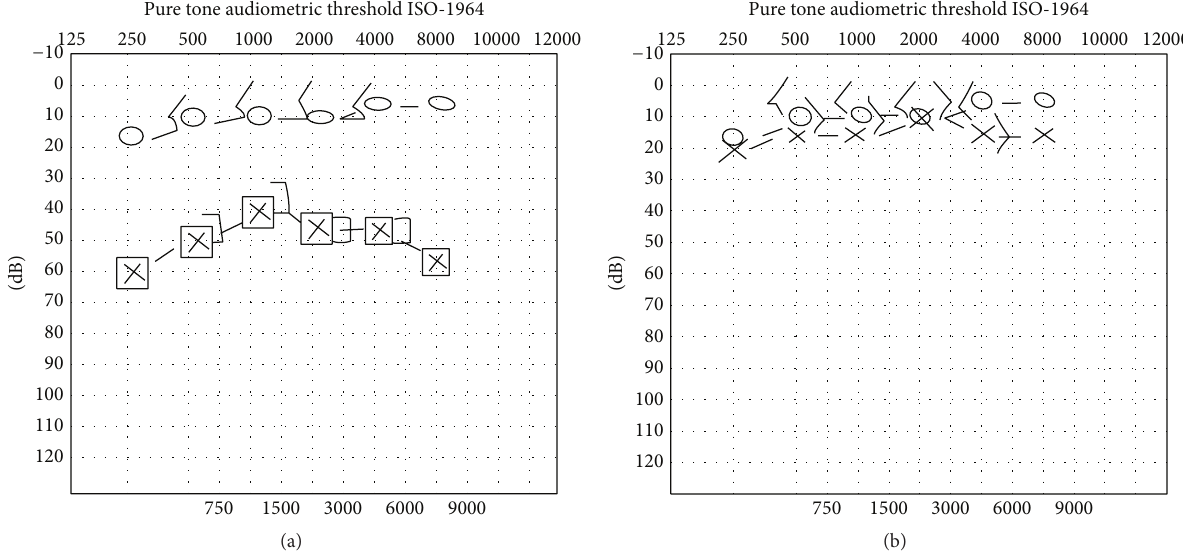
Figure 3: Audiographic results before and after treatment. (a) Before treatment. (b) After